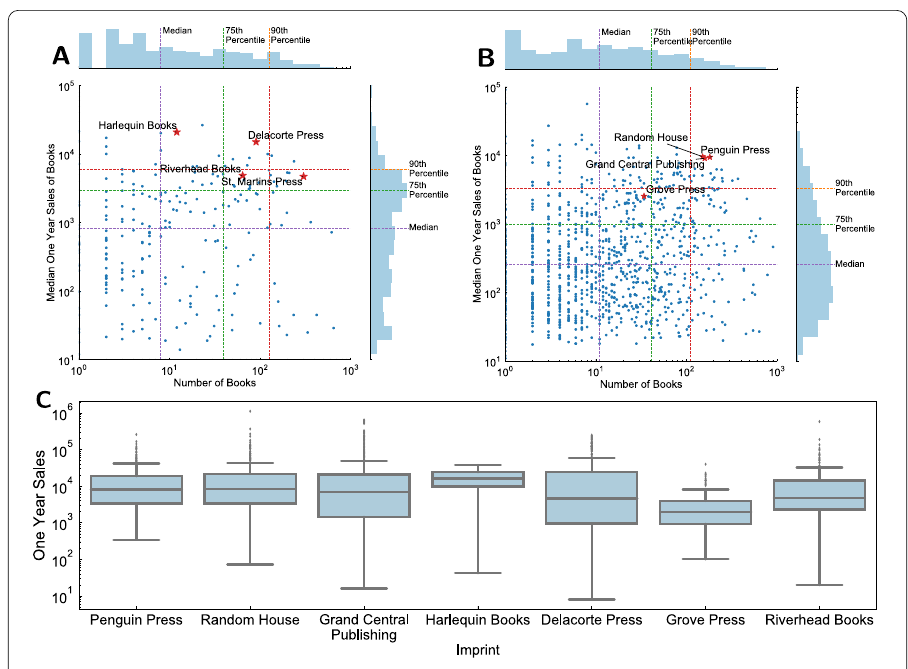
Figure 4 Number of books against median one year sales of books under each imprint for ( A ) fiction and ( B ) nonfiction. On the margins, we plot the distributions of the number of books and the median one year sales across imprints. We plot the median, the 75th percentile, and the 90th percentile as a reference line for both variables. We also highlighted some imprints discussed in Section 4.3 with red stars. ( C ) One year sales box plots for selected imprints. We see that for all imprints other than HarlequinBooks , the distribution of one year sales is very wide. The reason why HarlequinBooks is an “outlier” is that this imprint is small in size